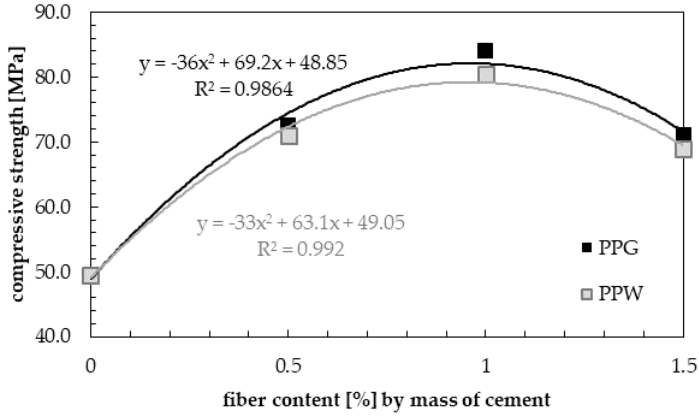
Figure 13. Compressive strength of hardened samples with different content of PPG and PPW.